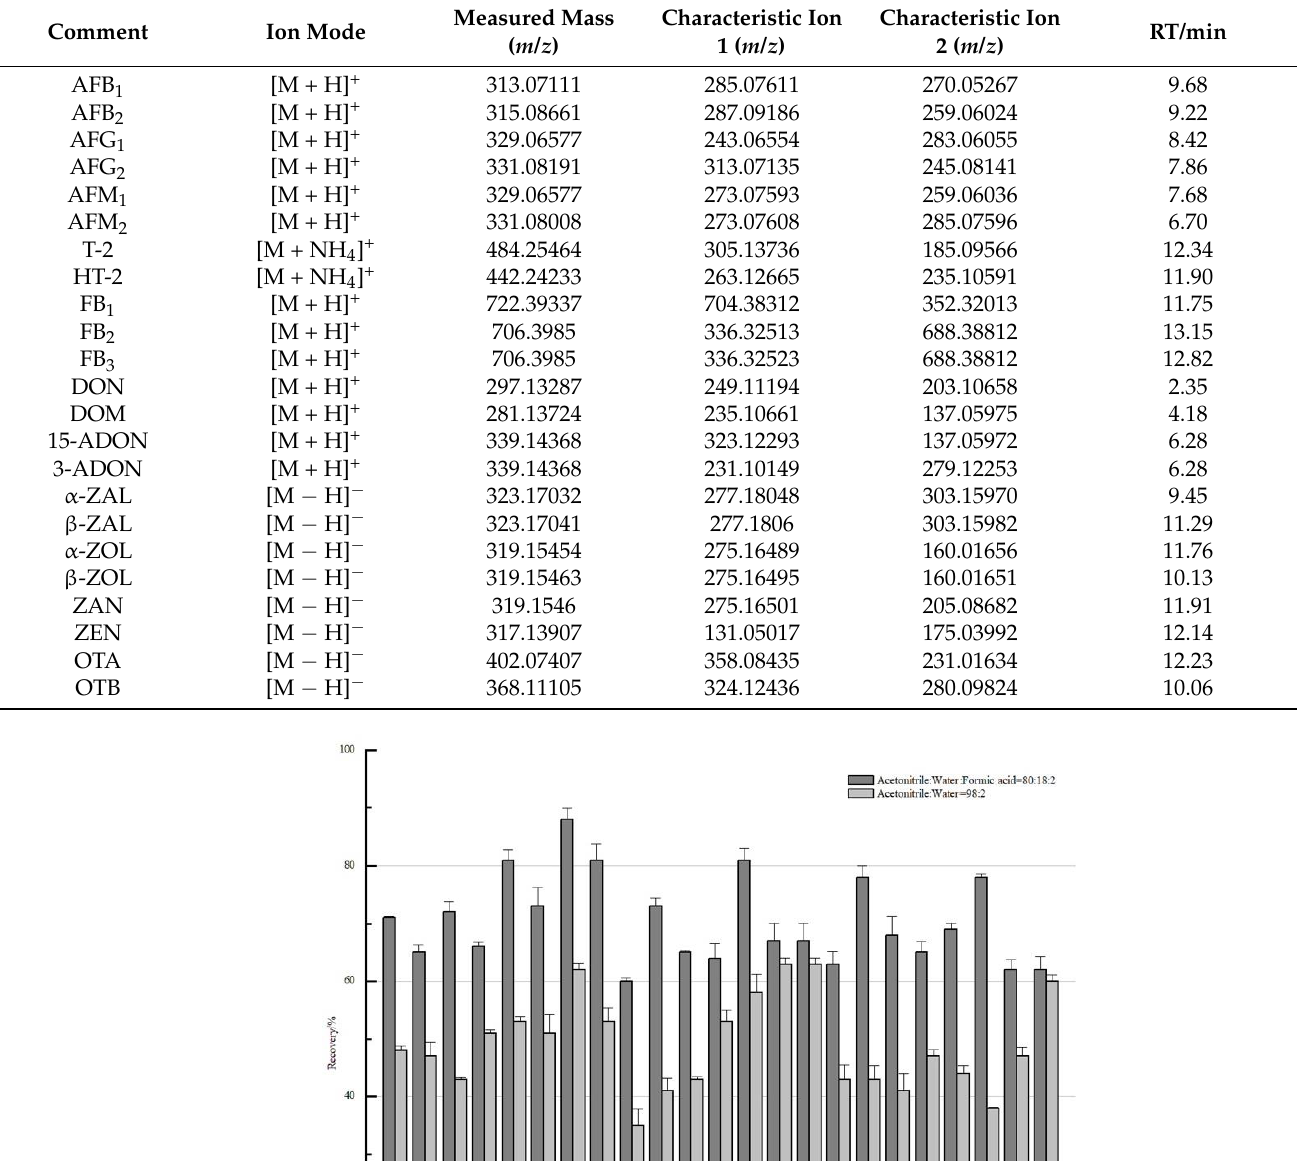
Table 2. Qualification parameters of 23 mycotoxins.